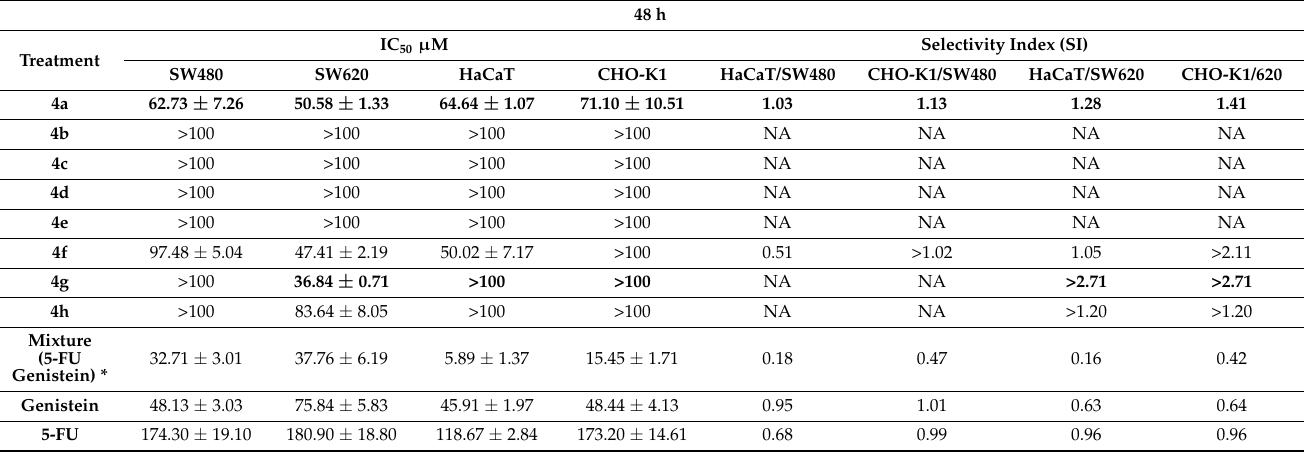
Table 1. Cytotoxicity of 5-FU-Genistein hybrids against SW480, SW620, HaCaT and CHO-K1 cell lines at 48 h. IC 50 values were obtained from dose response curves for each compound. Data are presented as the mean ± SE of at least three independent experiments. 48